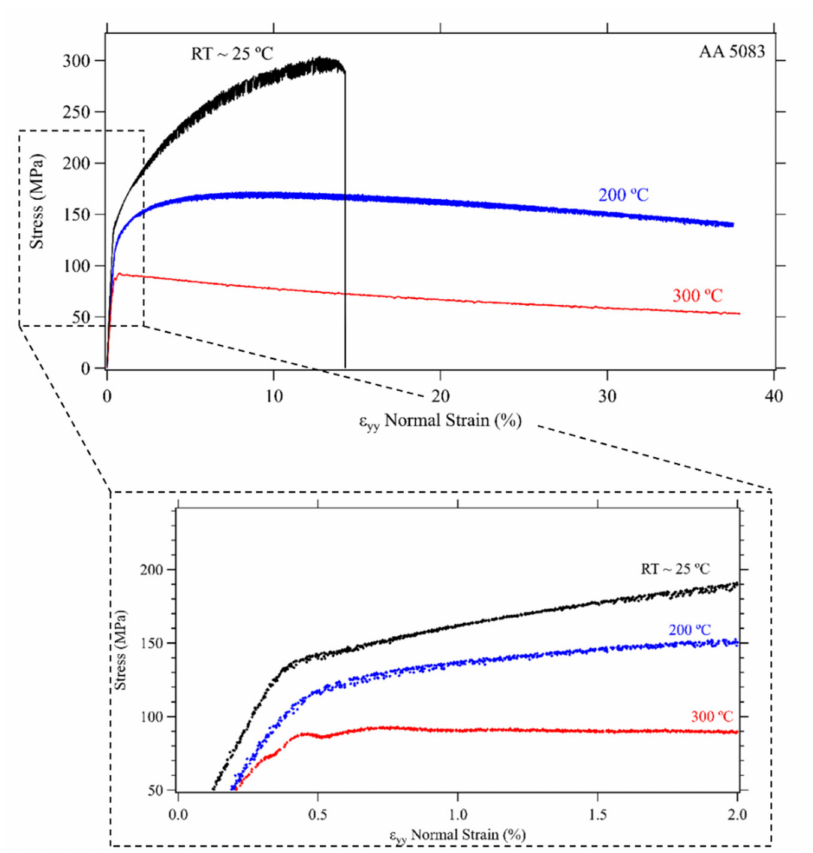
Figure 5. Stress–strain curves at different temperature conditions, representative cases. The reported strains were obtained from the load frame displacements and the conversion relations established in Figure 4 for one of the cases.